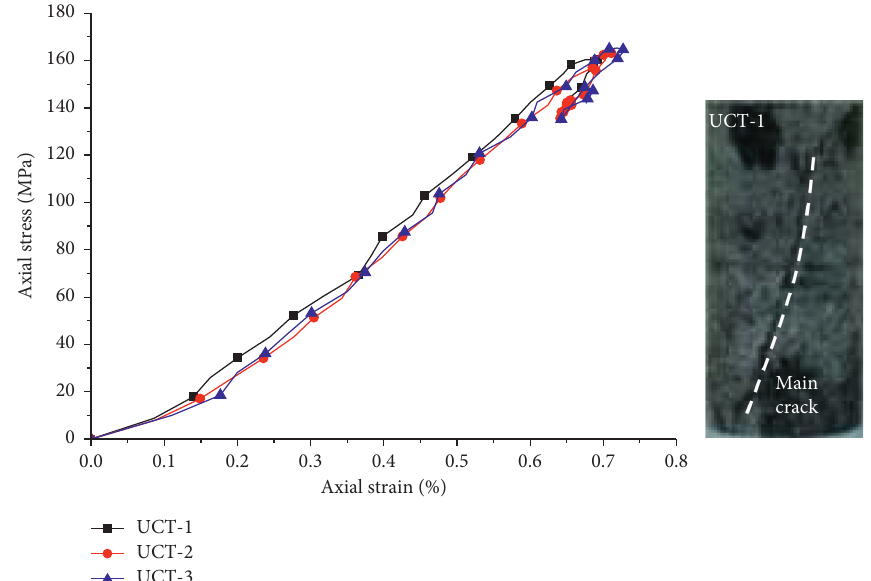
Figure 3: Stress-strain curves of Beishan granite for uniaxial compression test. Table 2: Uniaxial compressive test results of Beishan granite samples. Sample